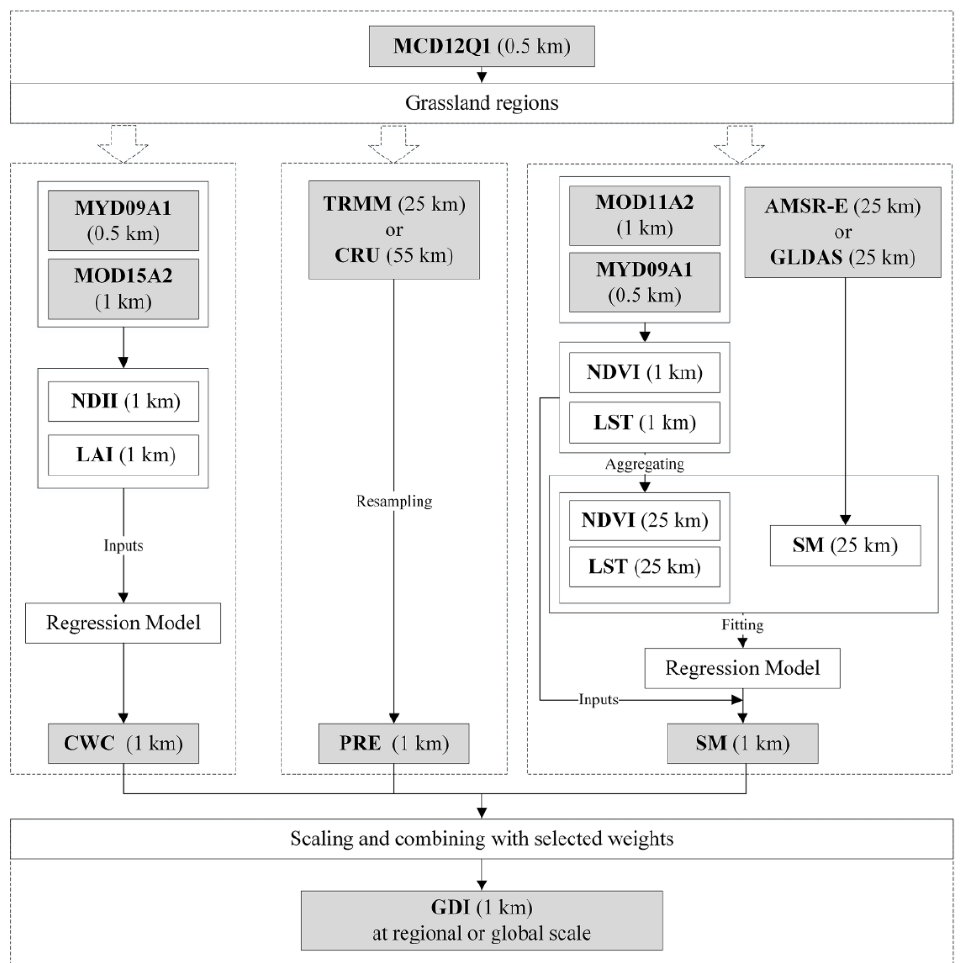
Figure 1. Flowchart of calculating GDI. The shown spatial resolution of TRMM, CRU, AMSR-E, and GLDAS are approximate